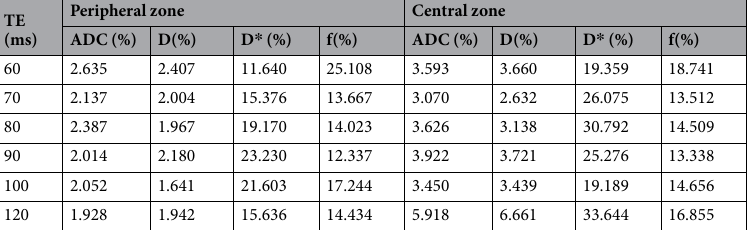
Table 1. Coefficient of variation (CV, in %) for the ADC, D, D * and f in the peripheral zone and central